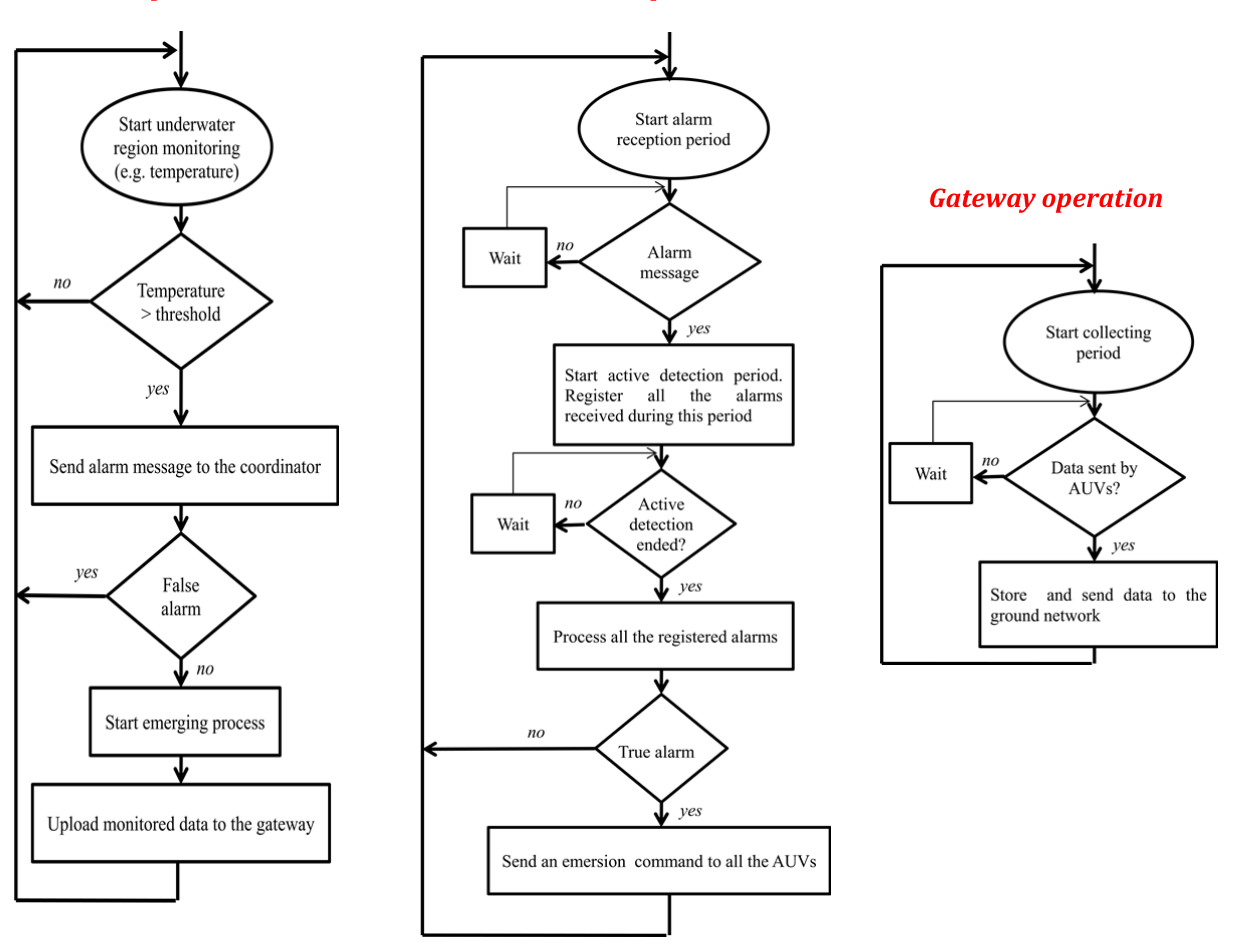
Figure 3. System operation specified for each main